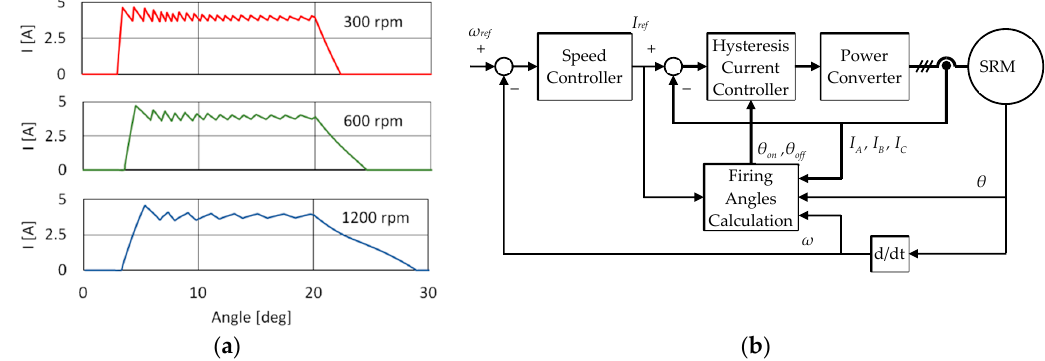
Figure 3. ( a ) Current waveform at speed 300, 600, and 900 rpm, 120 V; ( b ) block diagram of the firing angle modulation method.